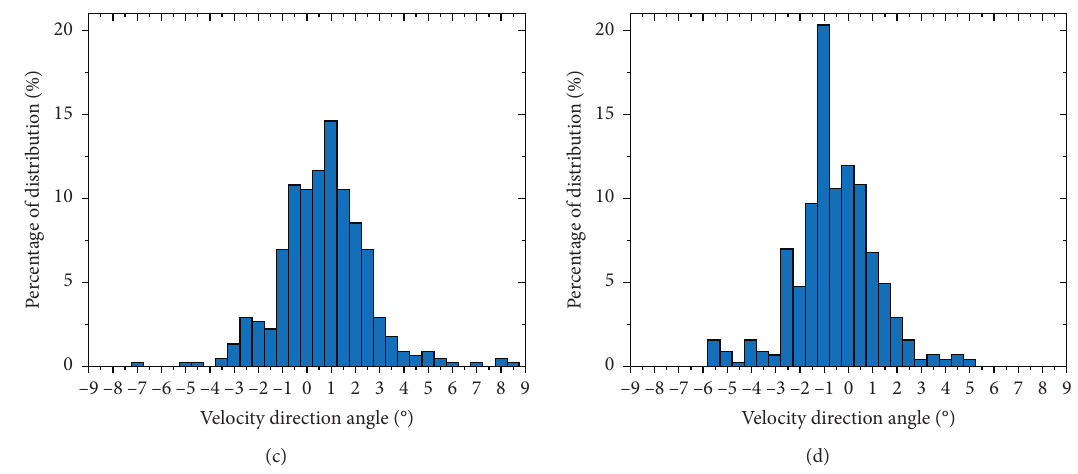
Figure 11: Distribution histogram of velocity displacement and velocity direction angle in the unidirectional flow scenario. (a) Velocity displacement distribution of real data. (b) Velocity displacement distribution of simulation results. (c) Velocity direction angle distribution of real data. (d) Velocity direction angle of simulation results.